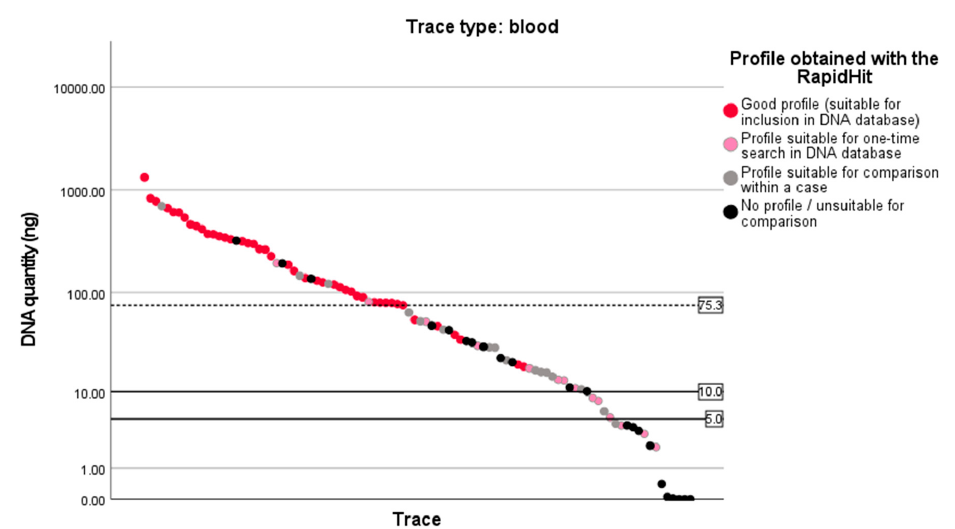
Figure A1. The distribution of the DNA quantity of blood traces (n = 97) of the laboratory samples analyzed by the regular procedure linked with the profiles generated by the RapidHit. The dotted line is the point from which mainly (86%) ‘good profiles’ were produced. The solid lines are the stated threshold of the RapidHit to derive a full DNA profile 0.25 µ L of blood, containing 5–10 ng of DNA.